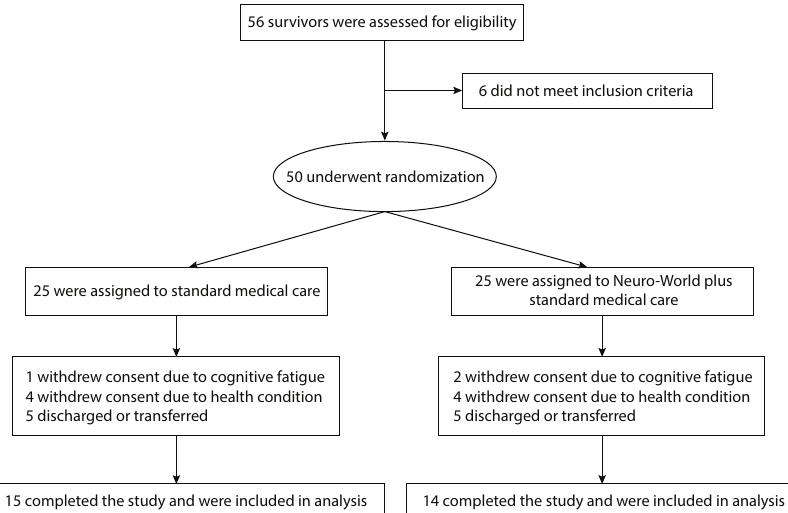
Figure 2. Participant Onboarding Procedure. Fifty-six volunteered chronic stroke survivors were screened for eligibility. Six were determined to be ineligible for the study because they scored less than 18 points in the initial MMSE assessment. Fifty participants were randomly assigned to the experimental vs. control groups. During the study, three participants expressed cognitive fatigue during gameplay and withdrew their consent. Ten participants were either discharged or transferred to other medical institutions. Eight participants withdrew their consents due to their health issues (e.g., headache or pain from arthritis), which were not related to the administration of Neuro-World . As a result, 14 participants from the experimental group and 15 participants from the control group completed the study. All 14 participants from the experimental group who stayed in the study completed the entire 24 sessions of Neuro-World gameplay (i.e., twice a week for 12